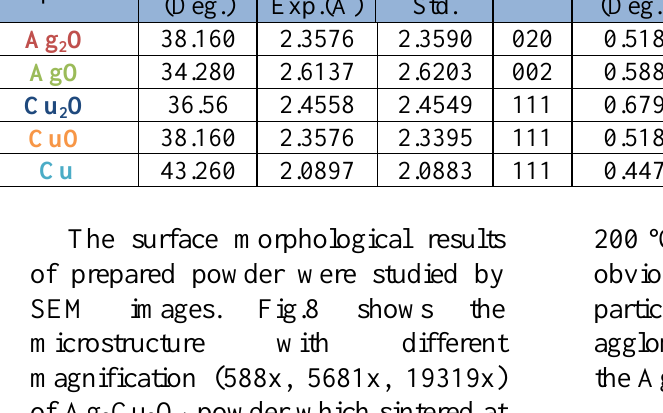
Table 7: Structural parameters viz. inter-planar spacing, crystallite size and miller indices of Ag Cu O films sintered at 600 °C and annealing at 200 °C for half an hour. 2 2 4 2θ d d FWHM G.S hkl hkl compounds hkl phase card No. (Deg.) Exp.(Å) Std. (Deg.) (nm)